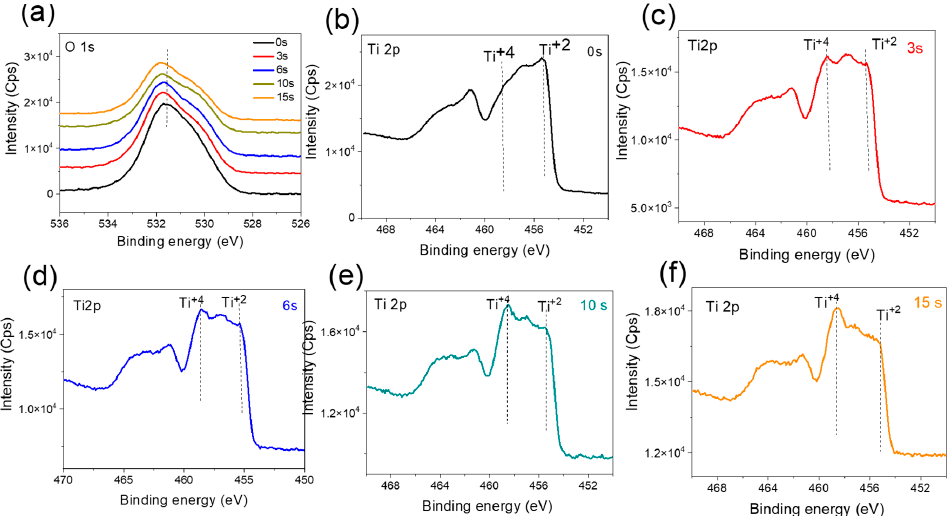
Figure 8. XPS data for nitrogen ‐ doped, annealed TiO 2 film (TiO 2 ‐ annealed600 ‐ NH 3 ) before and after